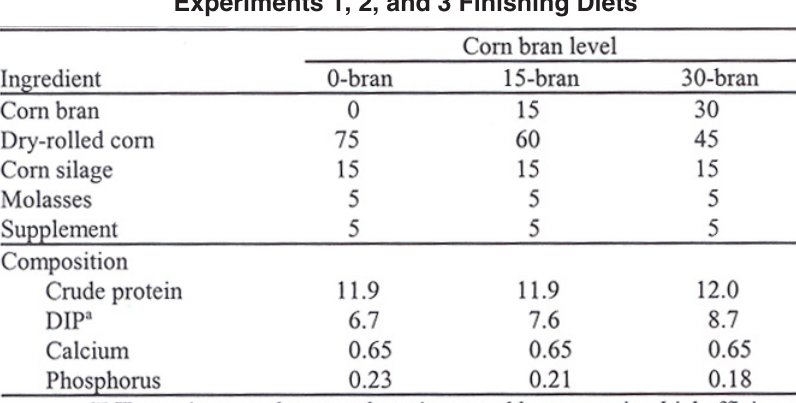
Experiments 1, 2, and 3 Finishing